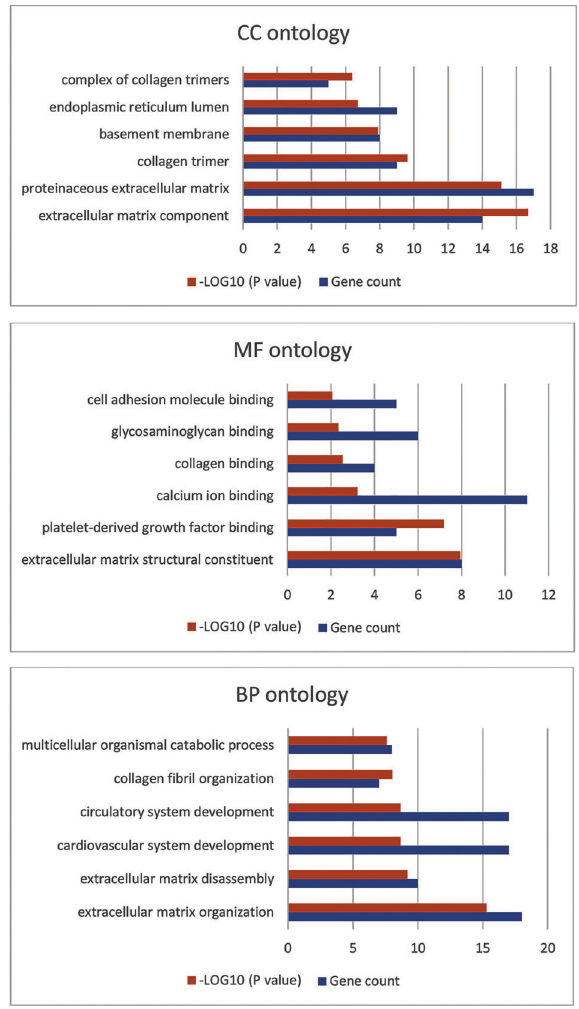
Figure 2. Bar plot of representative Gene Ontology analysis of ADAMTS5 co-expression gene. CC: extracellular matrix (ECM) component; MF: ECM structural constituent; BP: ECM organization.